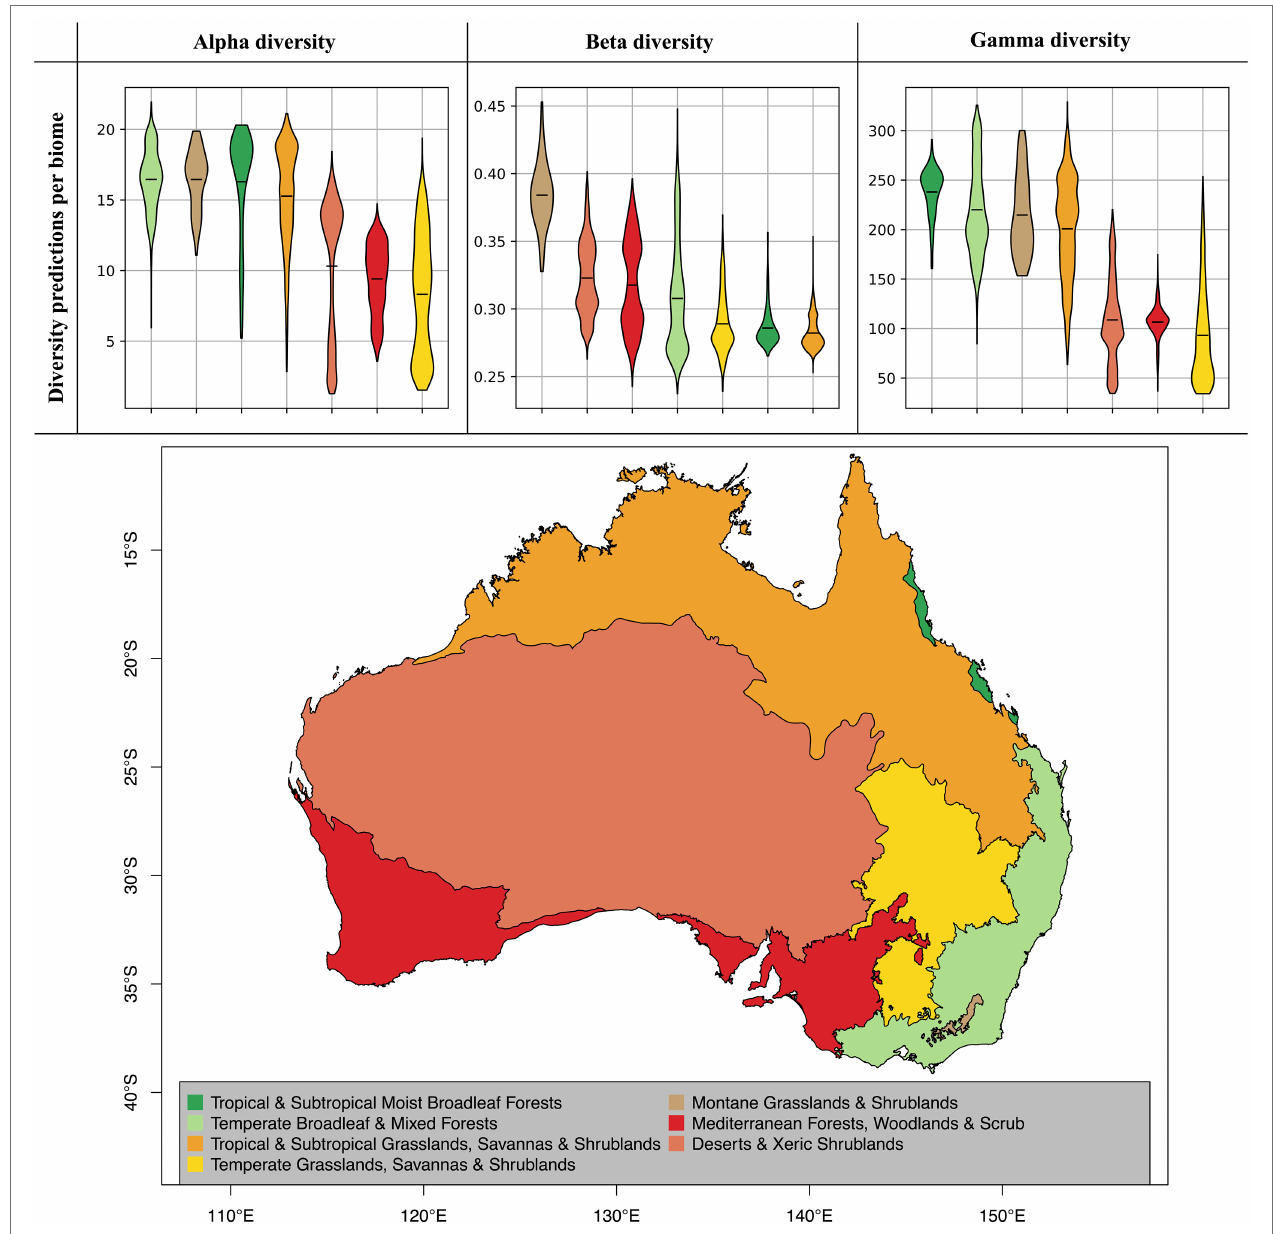
FIGURE 5 | Diversity predictions by biome. The violine plots show the range of diversity predictions across all grid cells within a given biome, excluding high uncertainty predictions (see Figure 4 ). The horizontal black lines inside the violine plots mark the mean estimate for each biome. The biomes, which are displayed on the map, were compiled from the Terrestrial Ecoregions of the World (TEOW) data (Olson et al.,